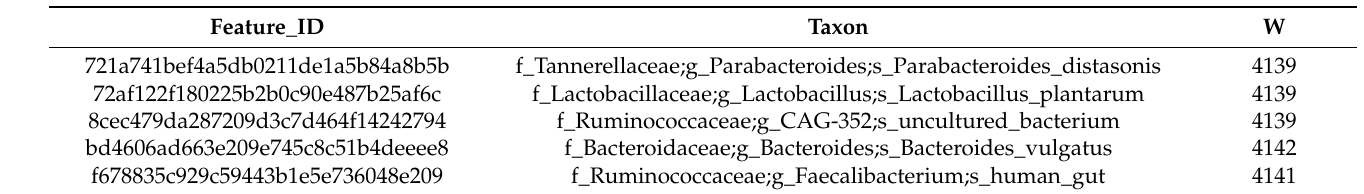
Table 4. Differentially abundant ASV (taxonomical unit assigned by q2-feature-classifier) identified by ANCOM after the course of 8-week oral administered probiotics.